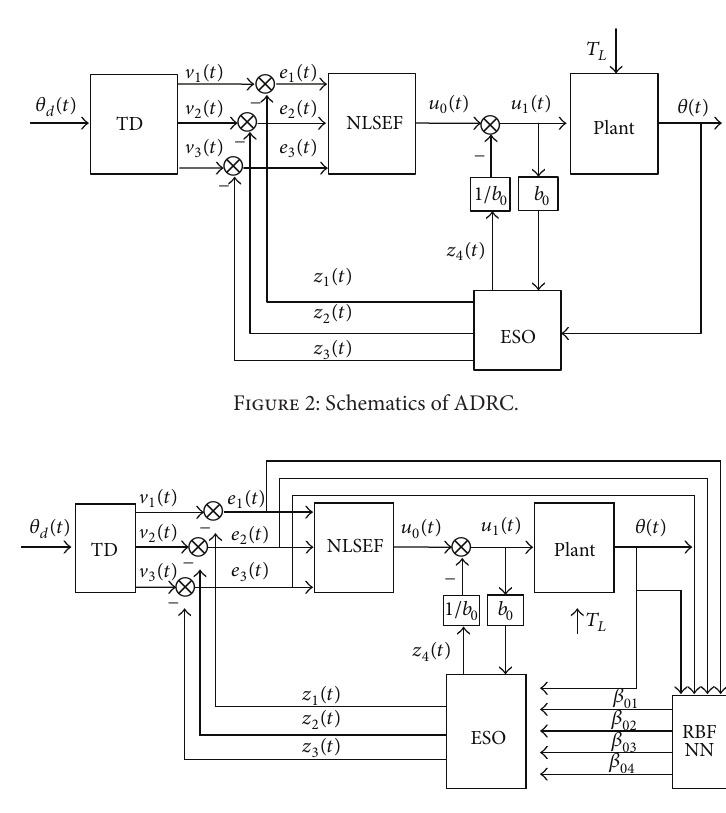
Figure 3: The diagram of ADRC based on RBF neural